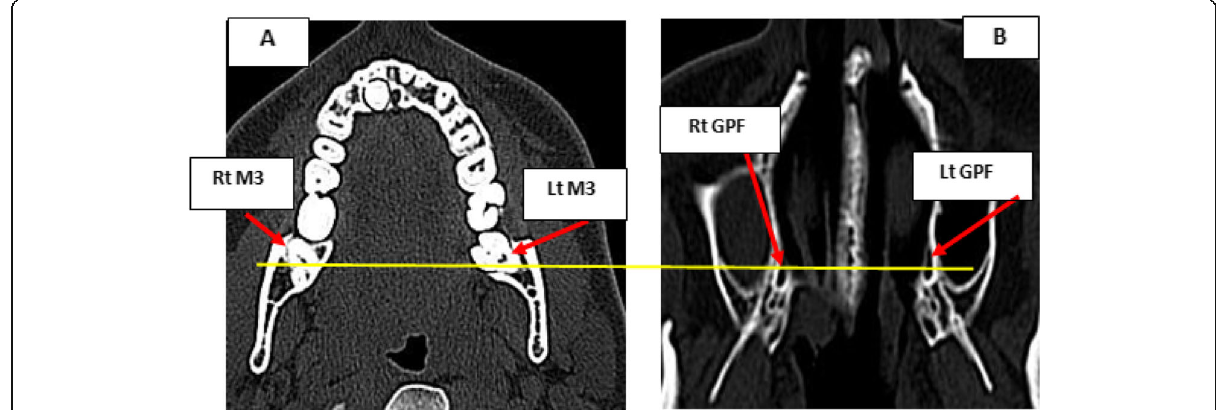
Fig. 2 A CT scan at the region of hard palate illustrating the right and left greater palatine foramina ( b ) located opposite the right and left third maxillary molars (M3) ( a )